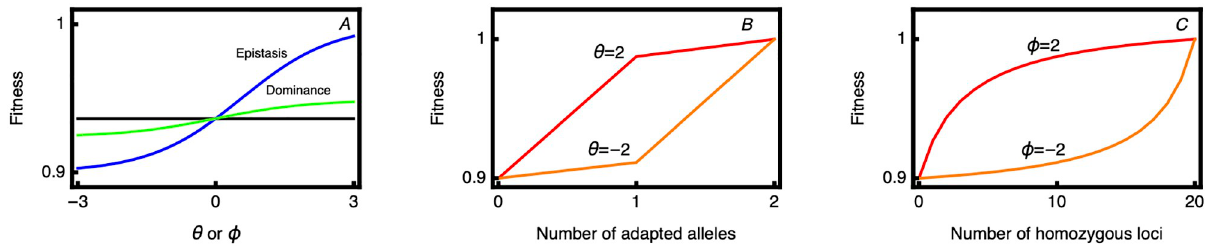
Fig 1. The fitness function showing the effects of dominance and epistasis. The total fitness cost is set at S = 0.1. Panel A shows the effect of changing the dominance and epistasis parameters in a genotype composed of 20 loci, 5 of which are homozygous for the adapted allele, and 10 of which are homozygous for the maladapted allele. The black line is the fitness value with no dominance or epistasis shown for reference. Note that in this example θ is the same for all loci. In panel B, the effect of dominance on fitness is shown for a single locus, as the number of adapted alleles is varied from 0 (homozygote) to 1 (heterozygote) to 2 (homozygote). The effect is shown for two values of the dominance parameter θ . Panel C shows the effect of the epistasis parameter in a genotype with 20 loci, as the number of loci homozygous for the adapted allele is varied. Two values of the epistasis parameter, ϕ , are